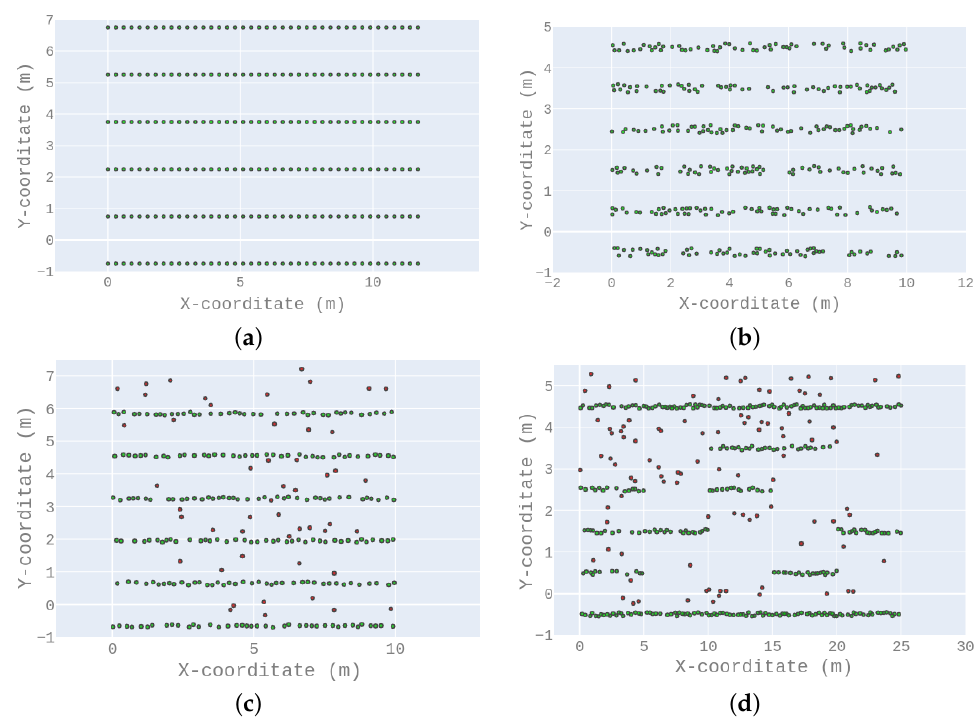
Figure 14. Simulated test crops. The green dots represent crops while the red dots represent weeds. ( a ) Crop 1; ( b ) Crop 2; ( c ) Crop 3; ( d ) Crop